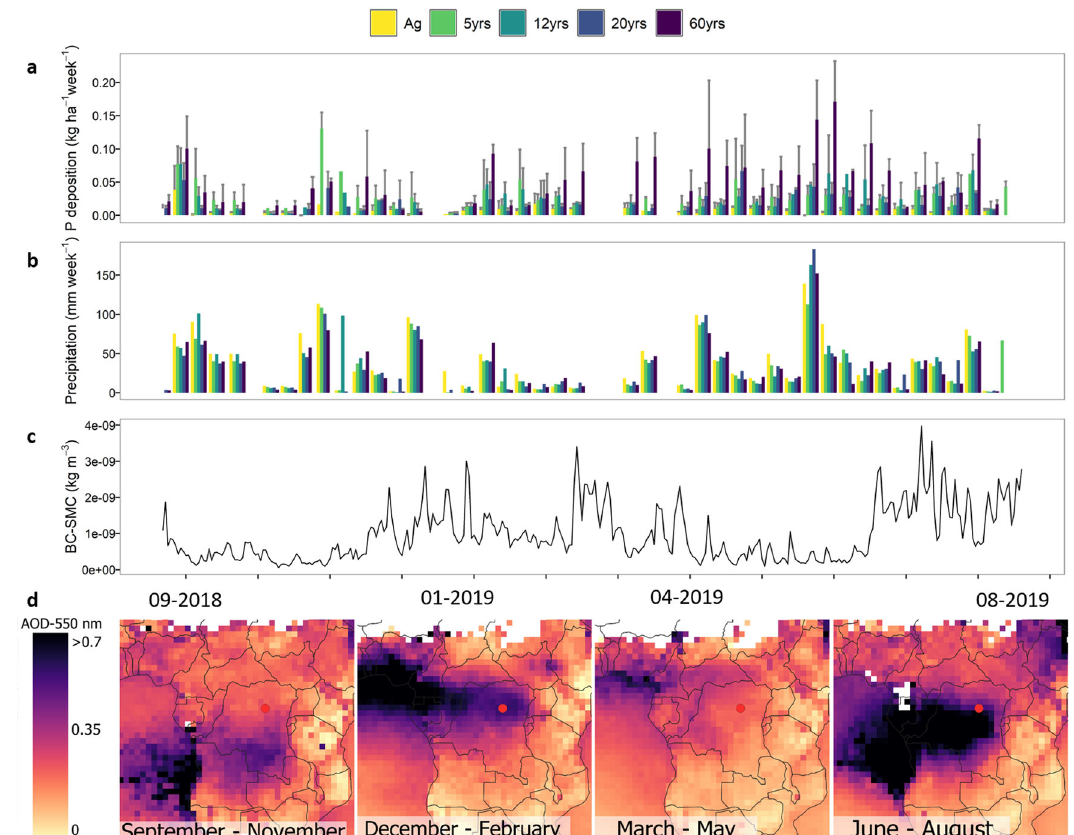
Fig. 4 Seasonality in phosphorus deposition and black carbon above the monitoring site. Temporal trends for open fi eld (Ag), 5- (5 yrs), 12- (12 yrs), 20- (20 yrs), and 60-year-old forest (60 yrs) over the monitoring period for phosphorus (P) deposition (mean ± standard deviation) ( a ), weekly precipitation ( b ), black carbon surface mass concentration (BCSMC) ( c ) above our site as extracted from MERRA2. Aerosol optical depth (AOD) at 550 nm, signaling biomass burning-derived aerosols detected over the study period by MODIS ’ Terra satellite at the larger region around the study site (red circle) ( d ).